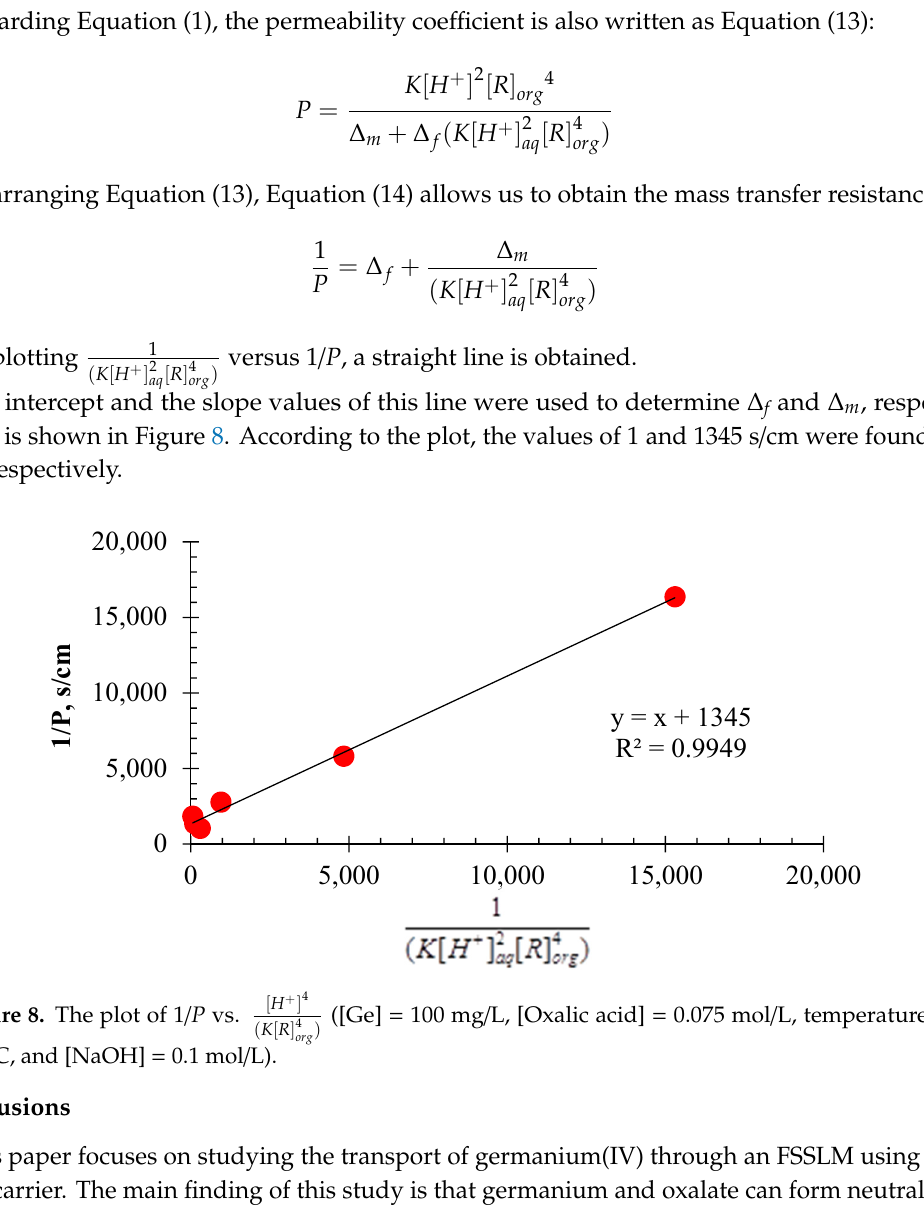
[ H + ] 4 ][ 44 RKH + ([Ge] = 100 mg / L, [Oxalic acid] = 0.075 mol / L, temperature of ([Ge] = 100 mg/L, [Oxalic acid] = 0.075 mol/L, temperature of ( K [ R ] 4 ) org )][( org